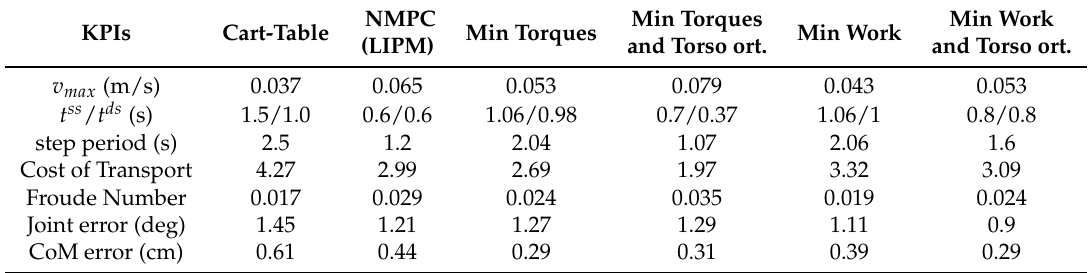
Table 3. [Hardware experiment result.] Key Performance Indicators (KPIs) measured for all 4 combinations of objective functions, in comparison with results with reduced models. The support times and step period refer to the ones of the periodic step. NMPC, Nonlinear Model Predictive Control. NMPC KPIs Cart-Table Min Torques